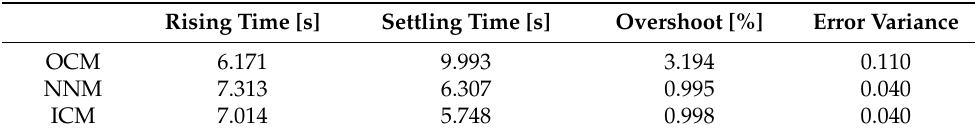
Table 7. Tracking performance indexes of three control methods.